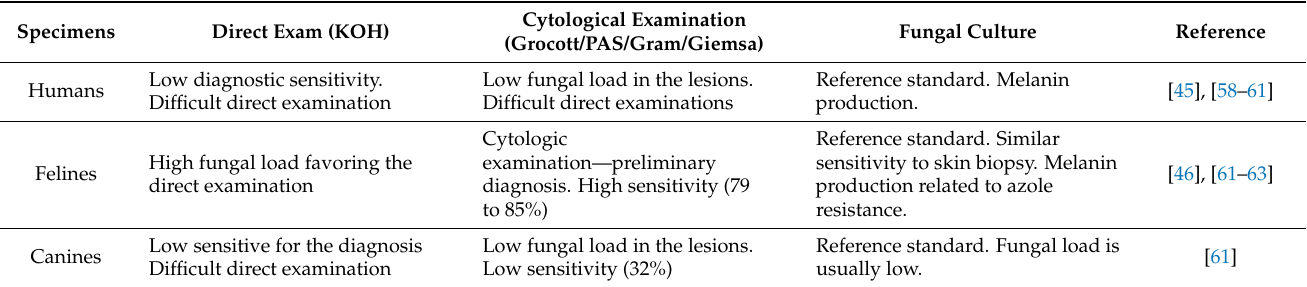
Table 2. Classical diagnostic methods for sporotrichosis in the analysis of clinical specimens (pus, secretions, biopsies).